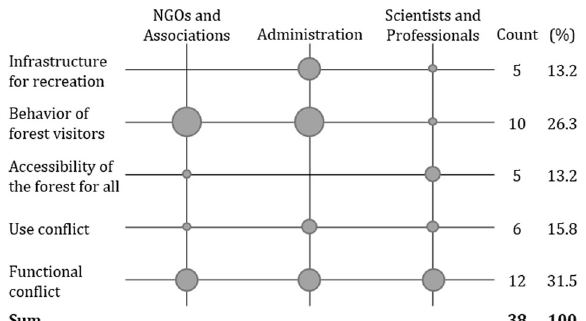
Fig. 2 Emerging con fl icts between climate change adaptation and the recreational function of CCF. Boxes represent the average quantity of segmented codes per interviewee per stakeholder group. Additionally, the total number of codes identi fi ed is